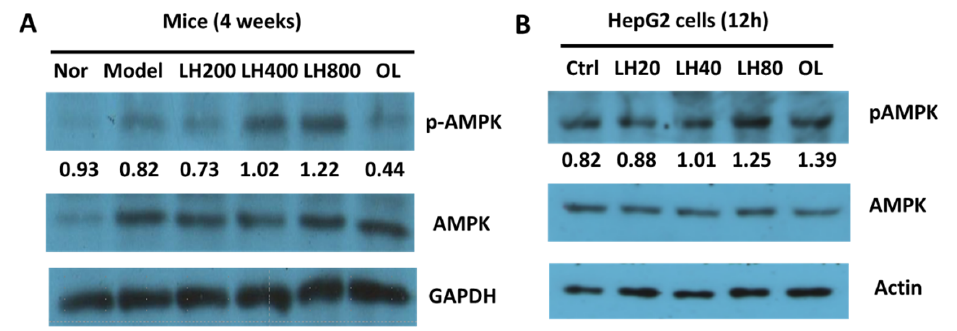
Figure 7. Effects of LH on pAMPK expression in (A) mouse livers and (B) HepG2 cells. Nor, normal group; model, high-fat control group; Ctrl, control. LH200, LH400, and LH800: groups orally treated with LH at dosages of 200, 400, and 800 mg/kg/day, respectively; OL60: group orally treated with OL at 60 mg/kg/day (n = 10). LH20, LH40, and LH80: LH (high pure mogroside V) at final concentrations of 20, 40, and 80 µg/mL, respectively (n = 3).